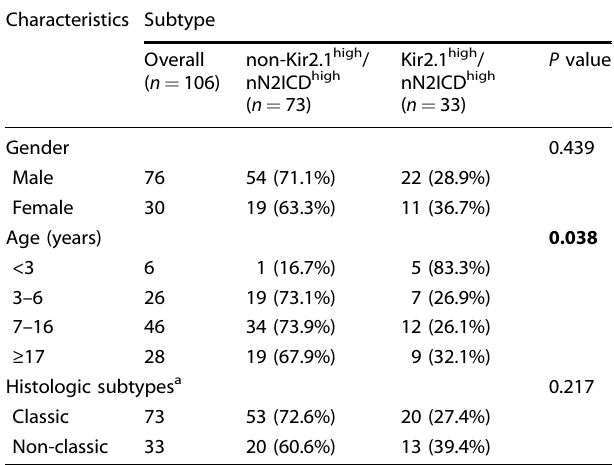
Table 2. The relationship between Kir2.1-nN2ICD status and clinicopathological features in non-WNT/SHH MBs Characteristics Subtype